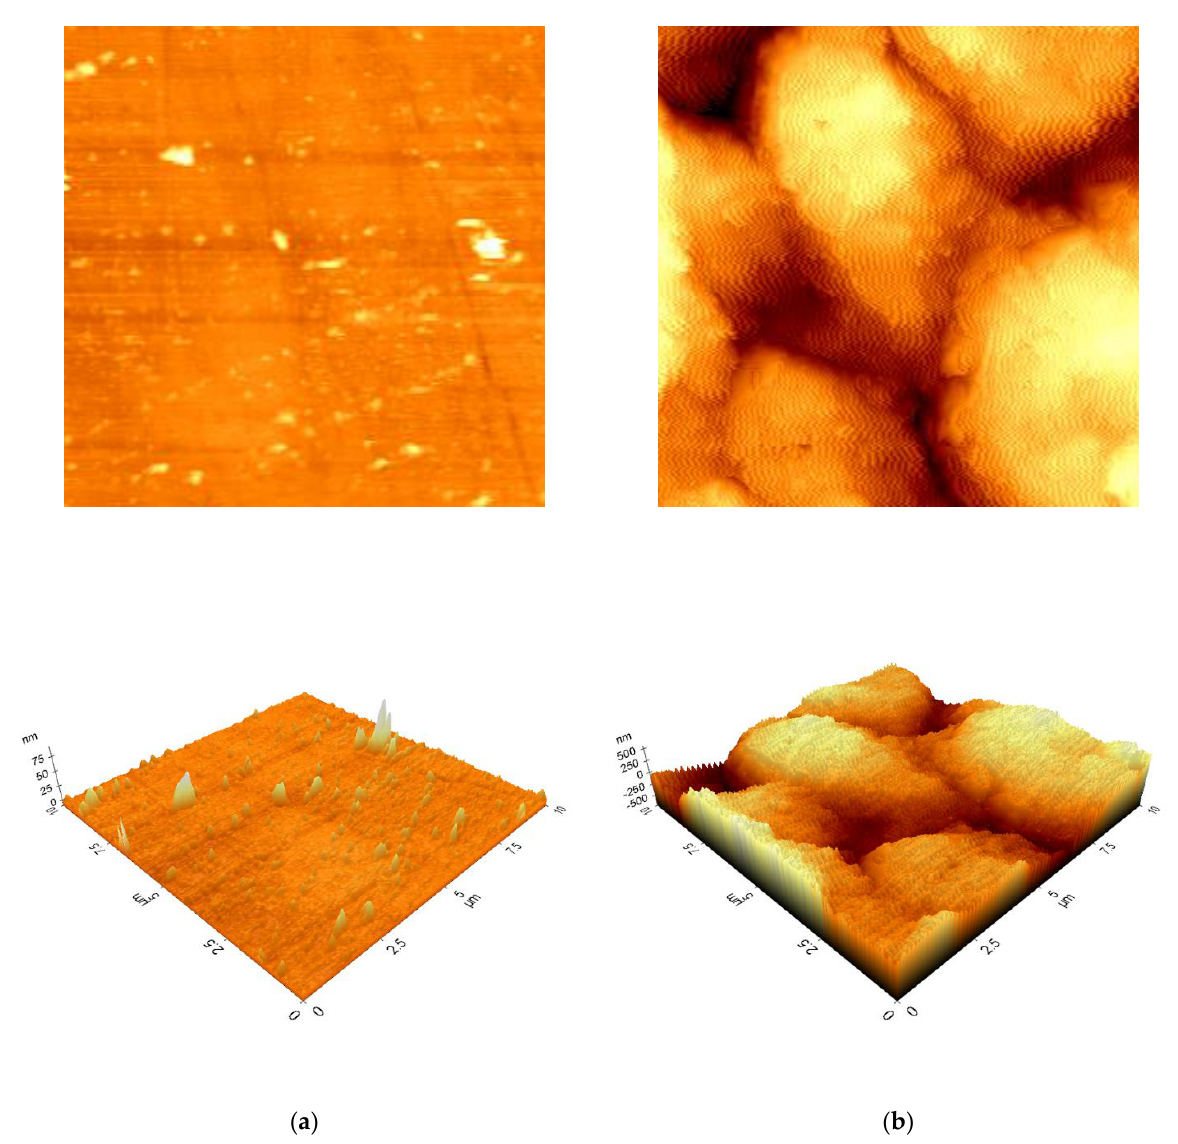
Figure 4. 2D/3D atomic force microscopy (AFM) topography images for polished ( a ) and cut after CW-CVD process ( b ) samples of Co-Cr alloy recorded in contact and noncontact mode, respectively.